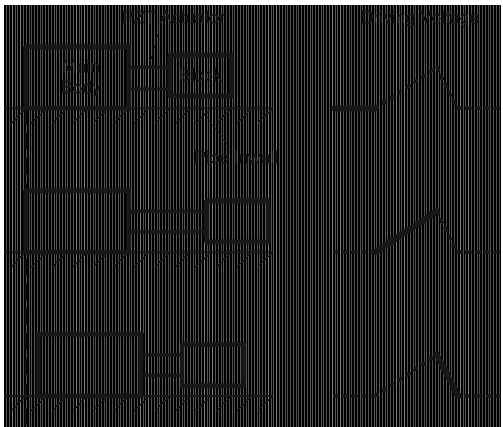
Figure 1. The working principle of the IDM robot.